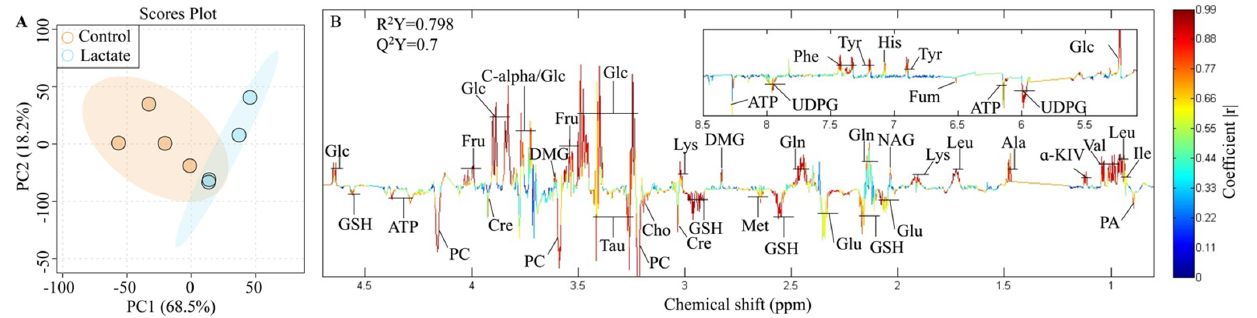
Figure 3. Differential metabolomics of the Caco-2 cells between the lactate and the control group. ( A ). Principal component analysis (PCA) scores of the complete metabolic profiles of all samples (N = 4). The light blue region is for the 95% confidence interval of the lactate treatment; the light orange portion is for the 95% confidence interval of the control group; and the light blue and orange dots are representative of the samples of the lactate and the control treatments, respectively. ( B ). Color- coded correlation coefficient loadings plots generated by comparing the spectra of the intracellular metabolites between the lactate and the control treatments.